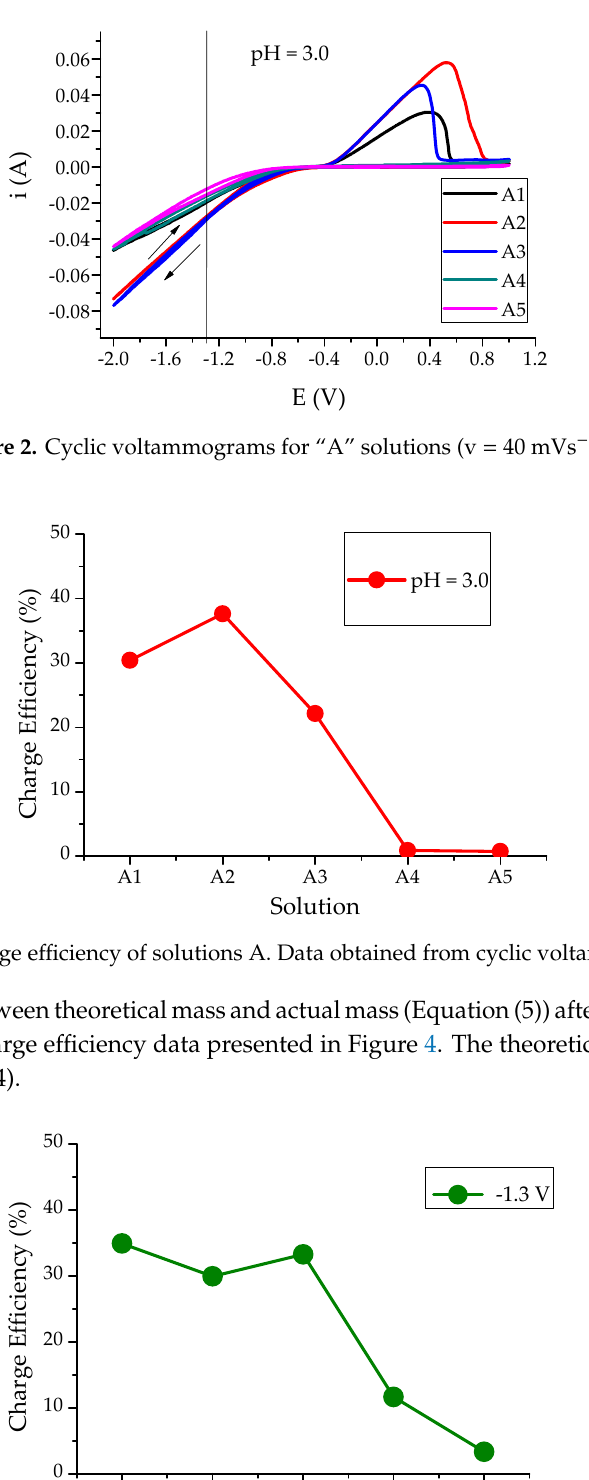
Figure 2. Cyclic voltammograms for “A” solutions (v = 40 mVs − 1 ).